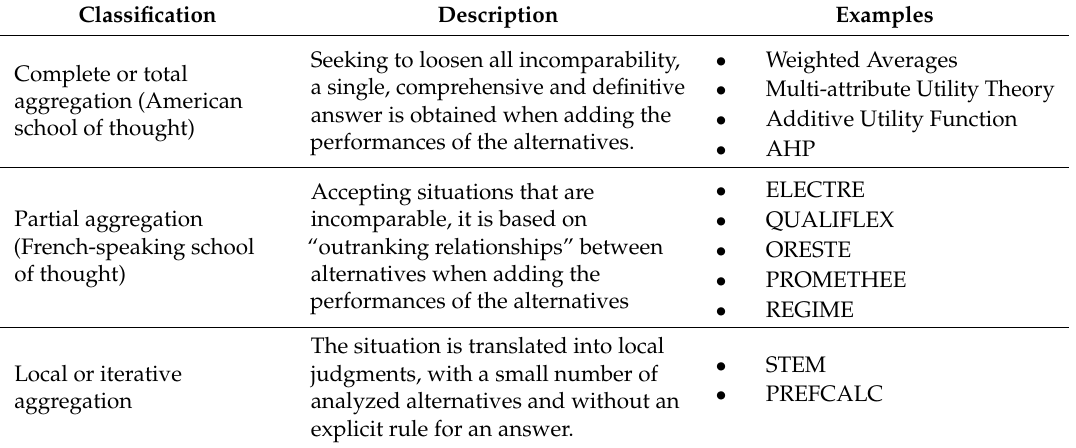
Table 1. Multi-criteria decision aid (MCDA) method classification